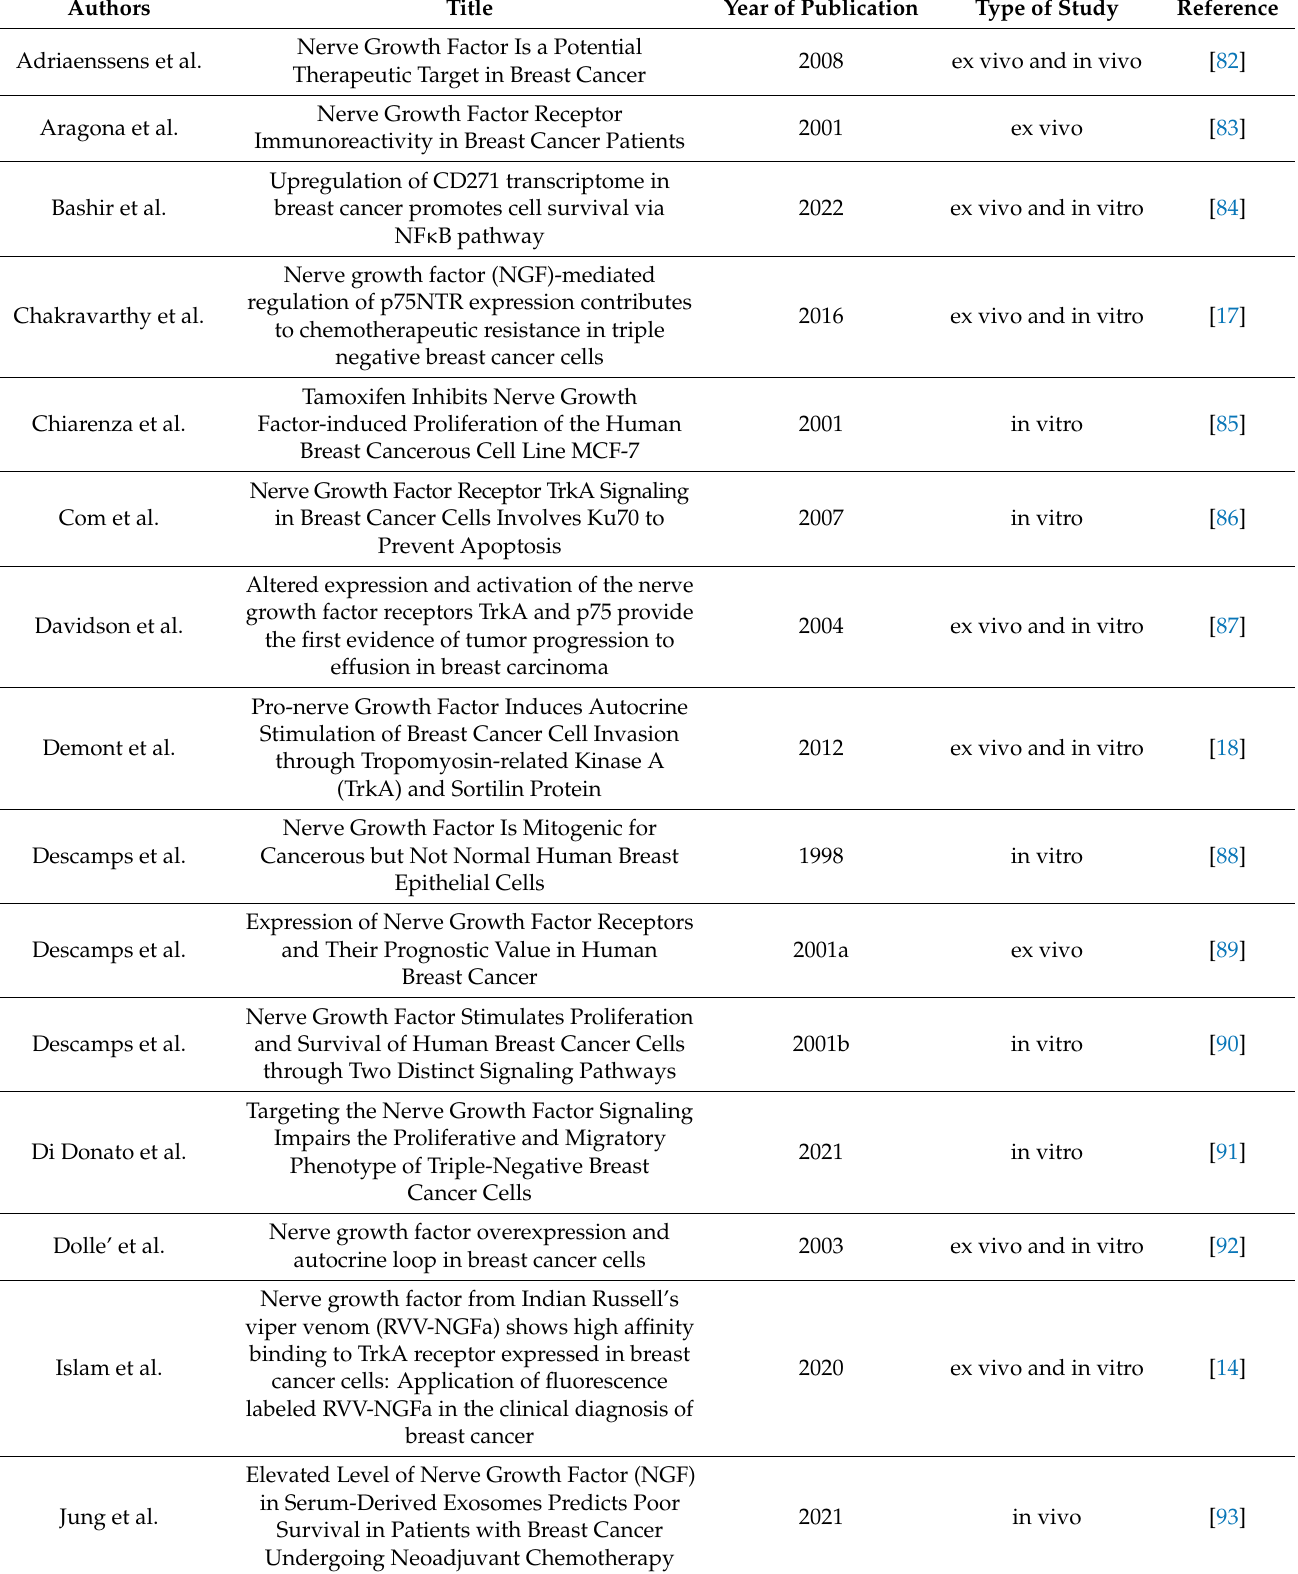
Table 2. Overview of included